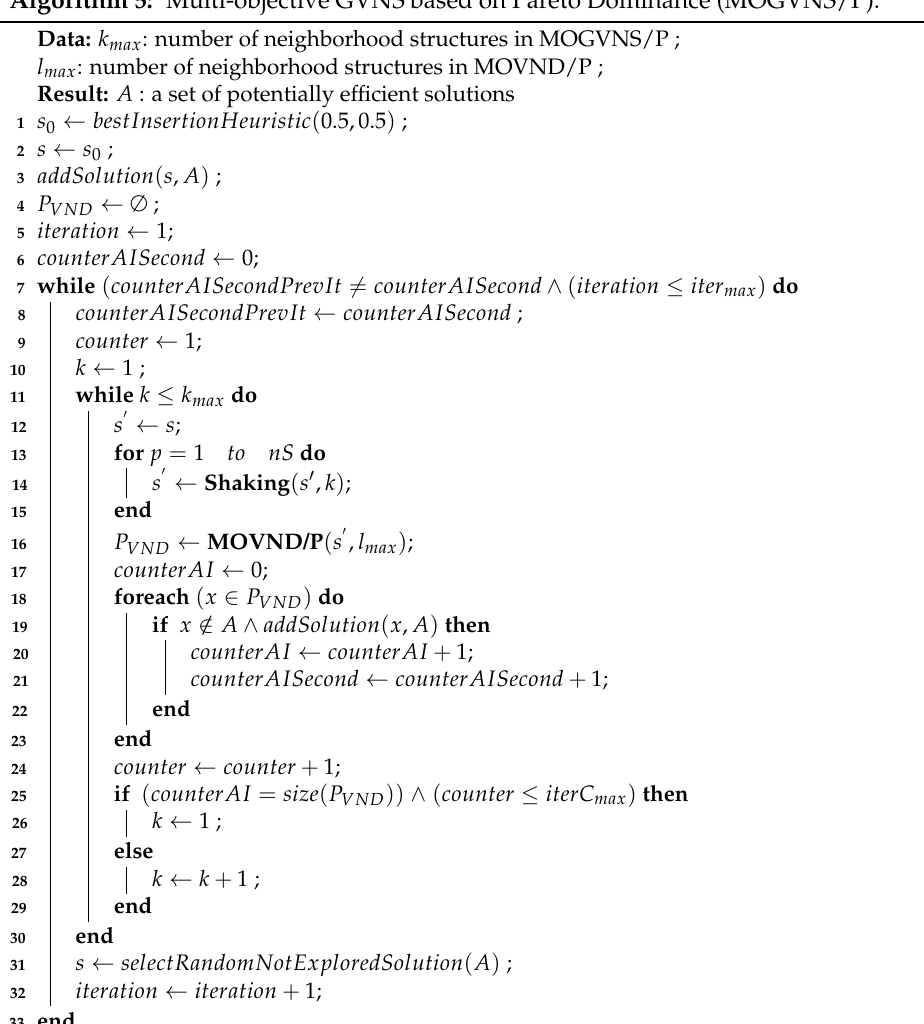
Algorithm 5: Multi-objective GVNS based on Pareto Dominance